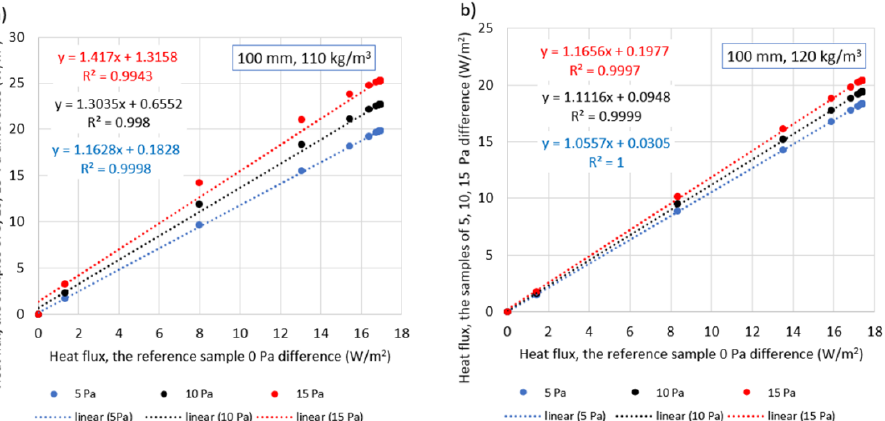
Figure 13. Comparison of the dependence of the heat flux in a wall with 100 mm insulation thickness on the pressure difference in the form of a comparison of the reference variant (0 Pa) with variants with a pressure difference of 5, 10 and 15 Pa, for a density of 110 kg/m 3 ( a ) and 120 kg/m 3 ( b ).